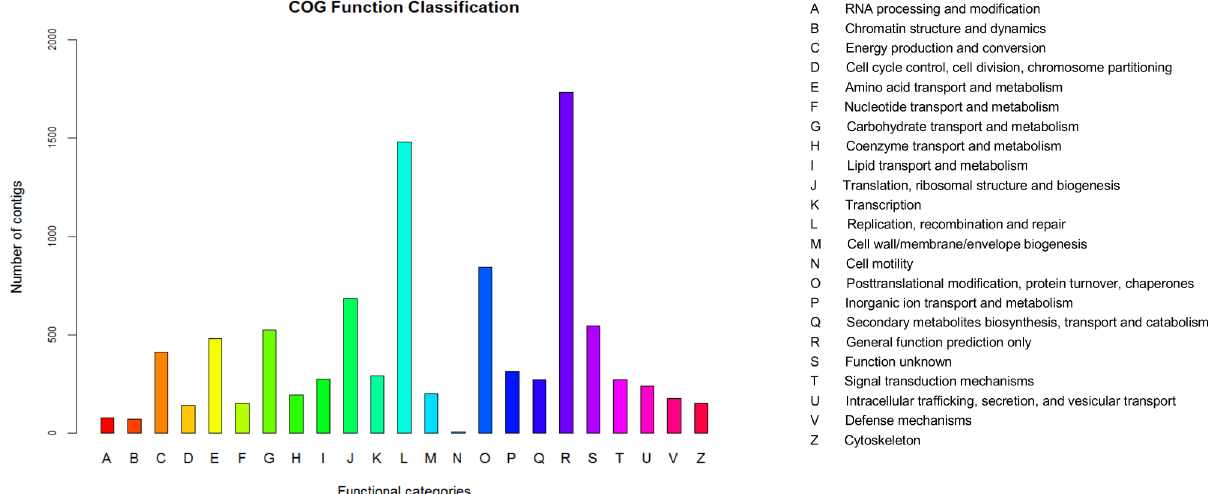
Figure 5. COG functional distribution of the H.brasiliensis bark transcriptome.